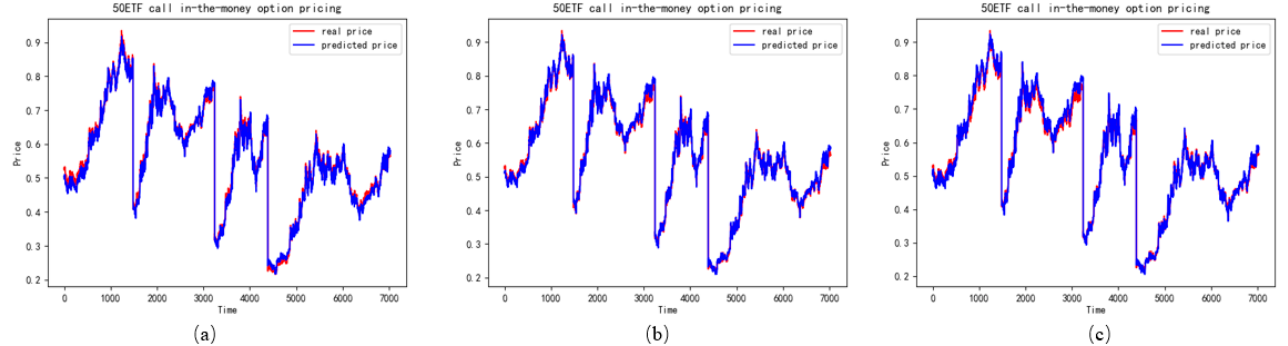
Figure 6. The comparison of the MAPE of different models considering realized skewness and realized kurtosis.